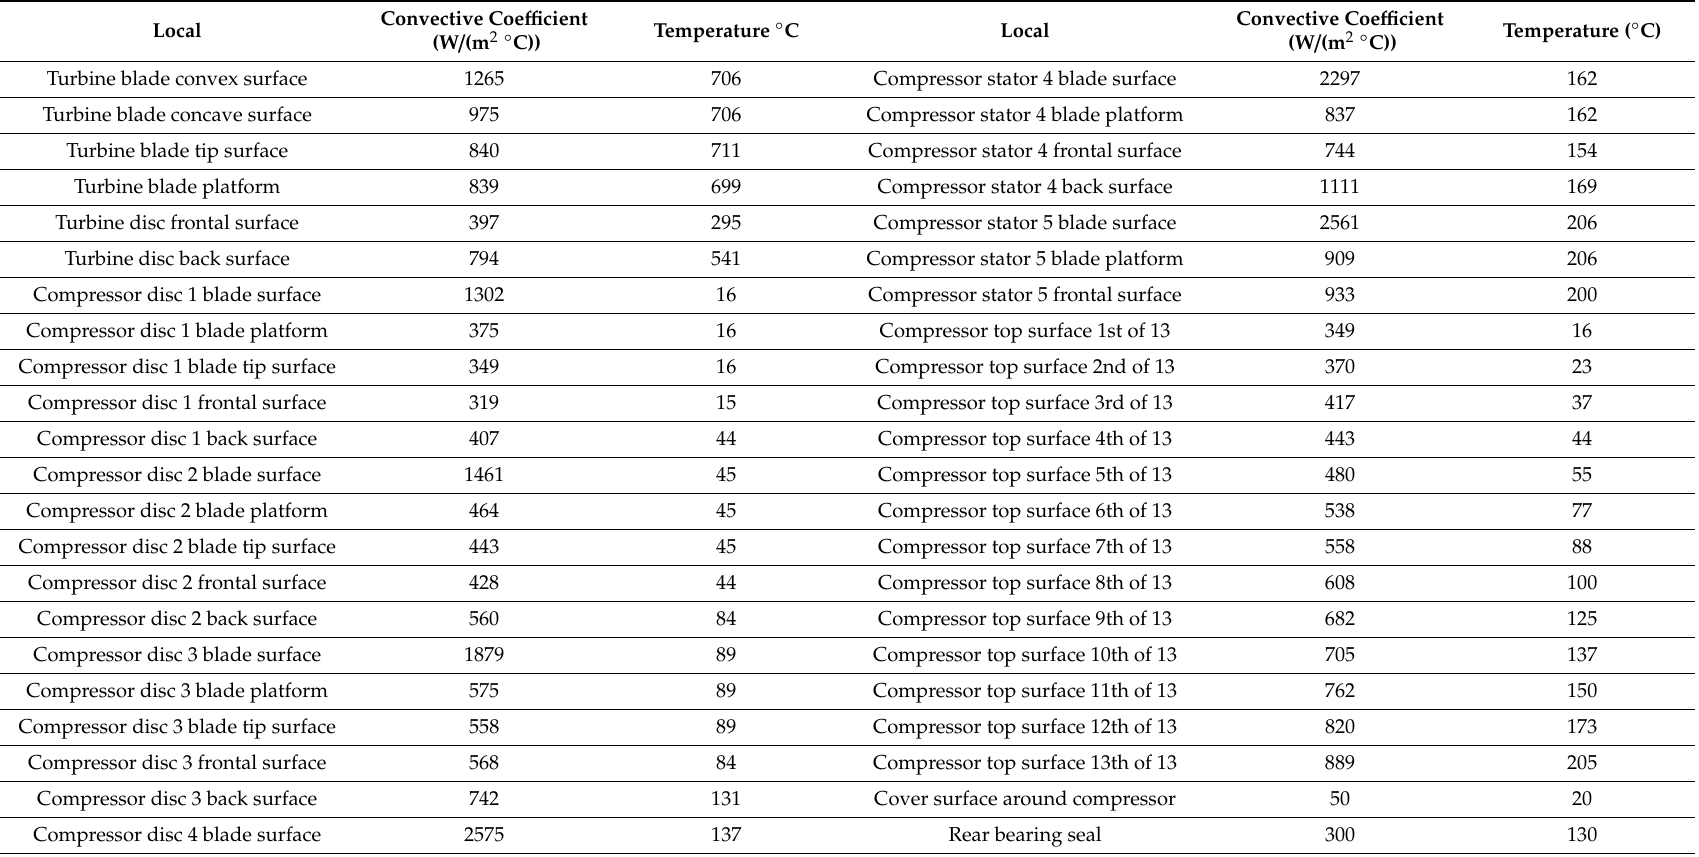
Table 4. Heat transfer coe ffi cients used in the computational